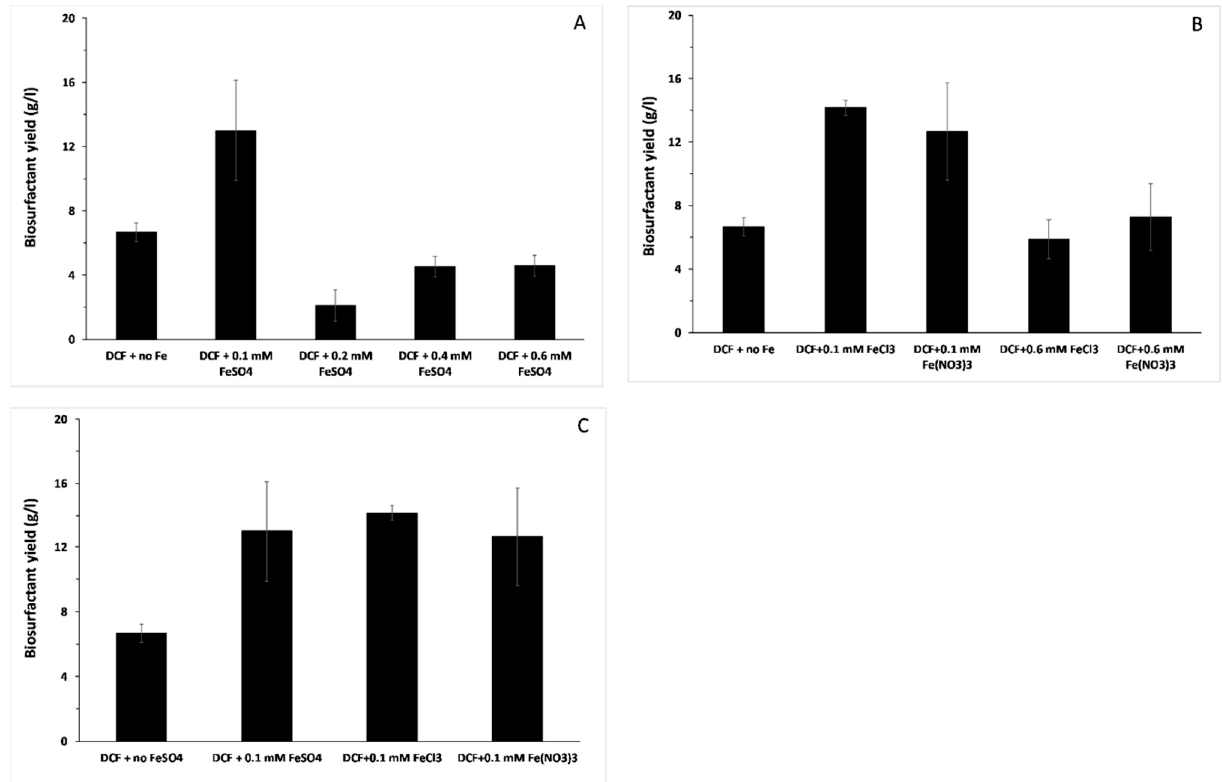
Figure 2. Biosurfactant production by P. citronellolis 620C with 1% ( v / v ) DCF as substrate, based on the product yield of the biosurfactant (BS) over drilling waste consumption: ( A ) with and without supplementation of different concentration levels of FeSO 4 , ( B ) with and without the addition of high and low concentration levels of FeCl 3 and Fe(NO 3 ) 3 , ( C ) comparison when different 0.1mM iron forms were supplemented.